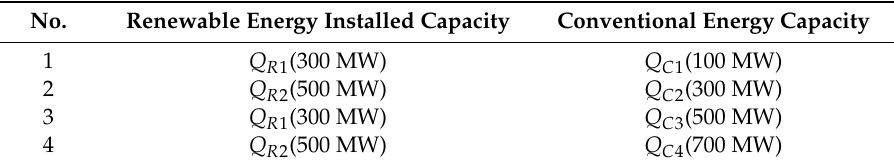
Table 2. Feasible solution set.